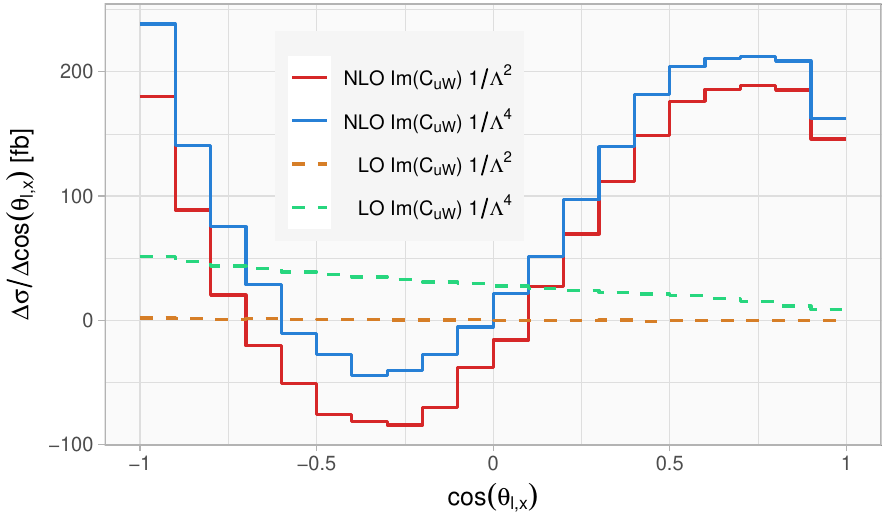
Figure 11. Distribution of cos (cid:18) l;x for the pure SMEFT contribution with Im C 33 1000 GeV. Shown are results at LO and NLO in QCD and at 1 = (cid:3) 2 in the SMEFT as well as higher order e(cid:11)ects 1 = (cid:3) 4 .